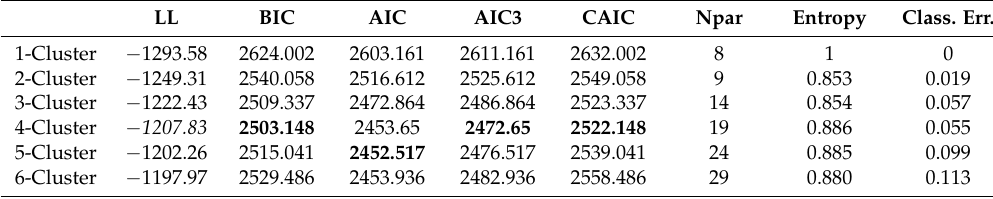
Table 2. Fit statistics of six models for selecting the optimal number of latent profiles.